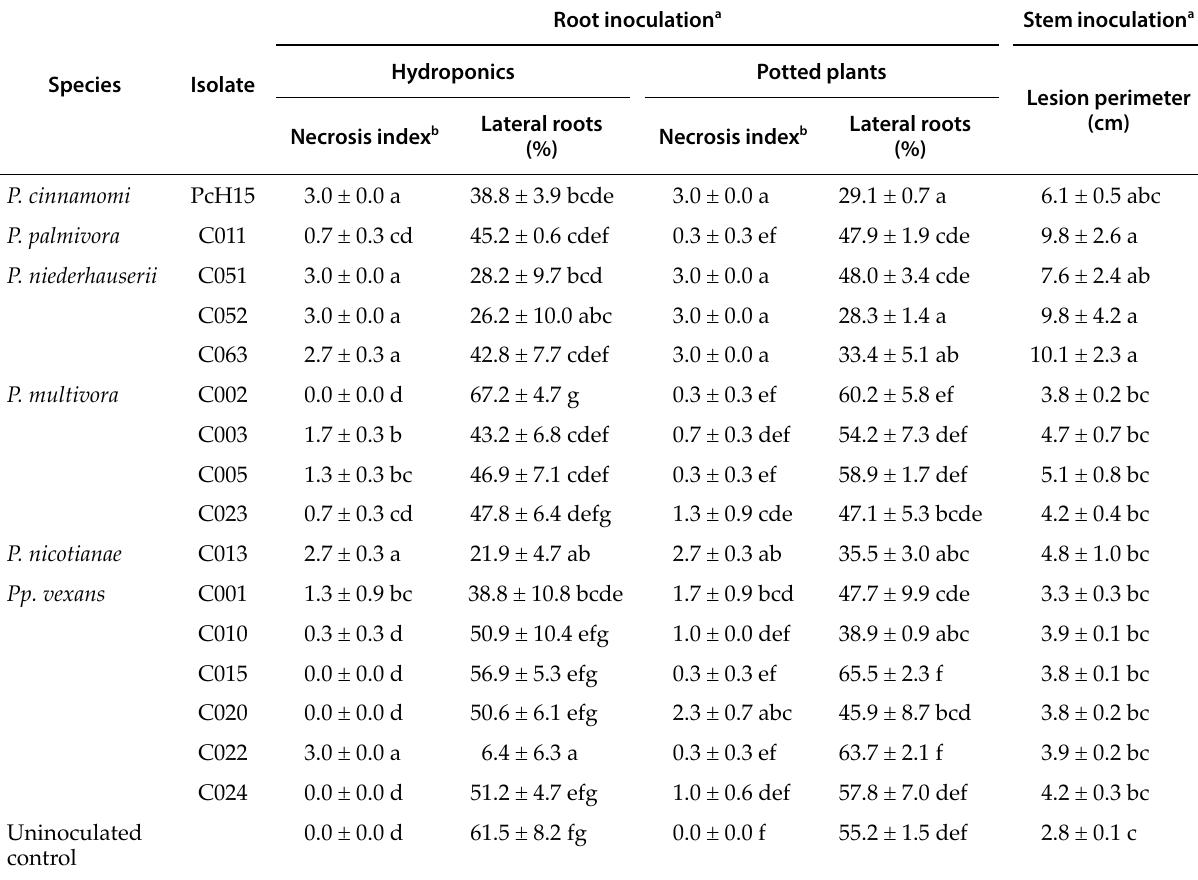
Table 3. Results of pathogenicity tests in avocado seedlings, showing the mean root necrosis indices, percentages of lateral roots with respect to the total root weights (root inoculation), and canker perimeters (stem inoculation). Root inoculation tests were carried out under hydroponic conditions and in potted